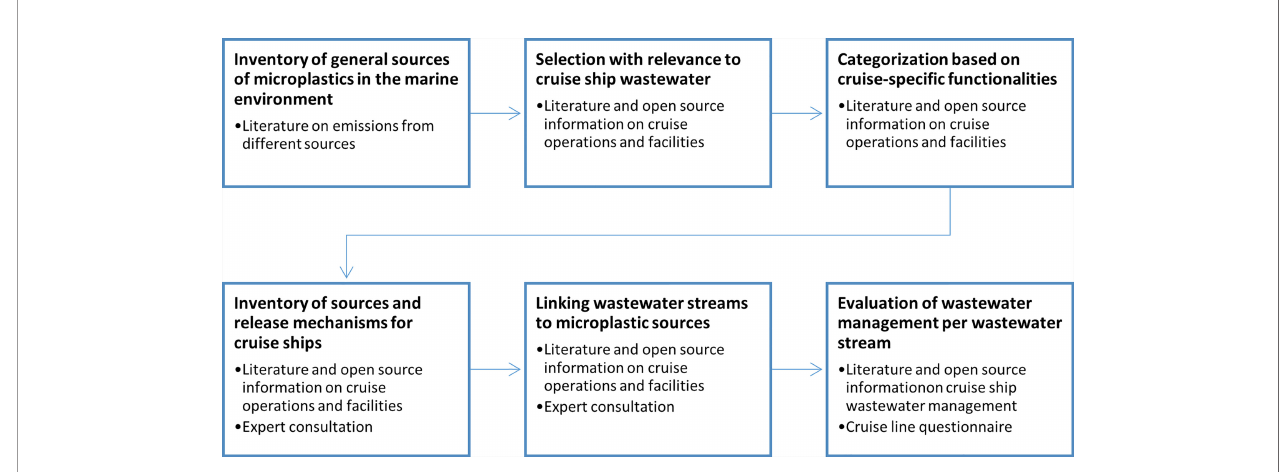
FIGURE1 | Research steps in the identi fi cation of sources and pathways of microplastics in cruise ship